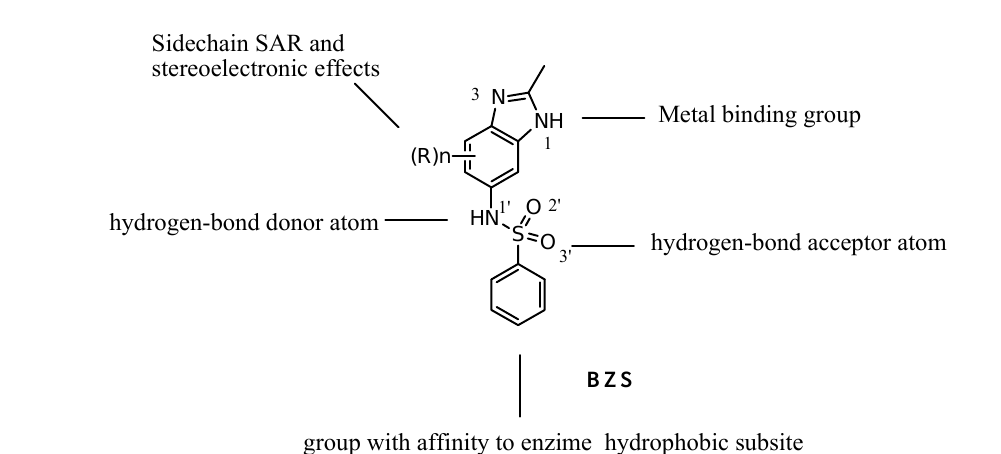
Figure 1. Design of BZS derivatives and the structure-activity relationships considered in this study.